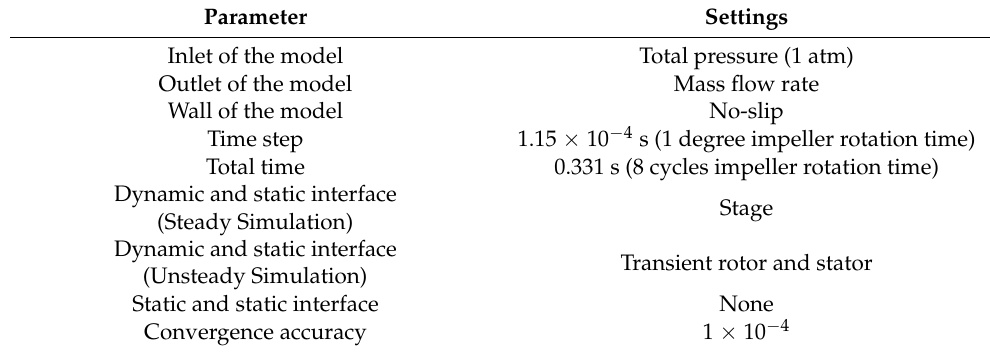
Table 1. Numerical simulation